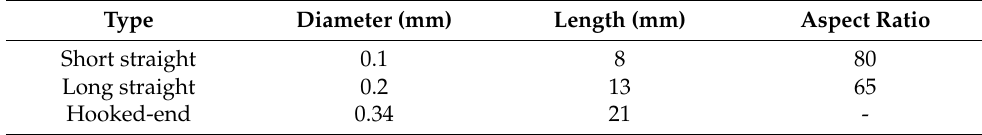
Table 2. Dimensions of three types of steel